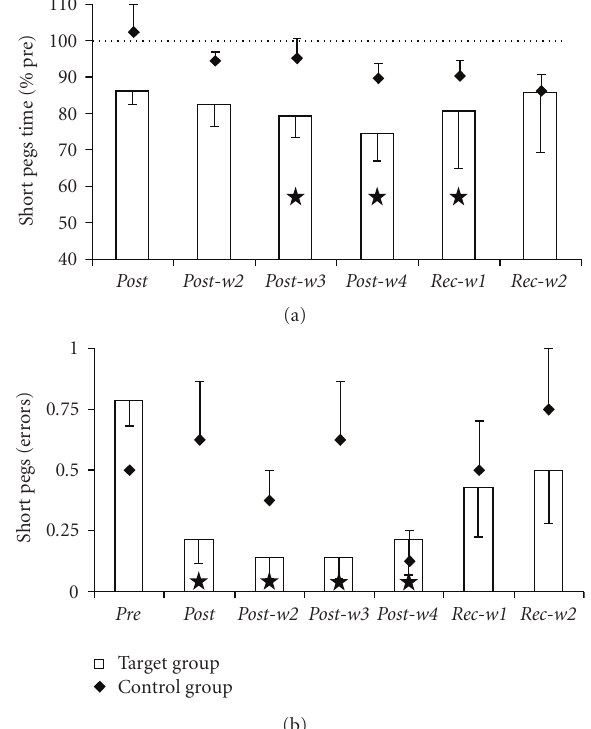
Figure 4: Fine motor performance in pegboard testing. (a) Percentage change of time to fulfill the pegboard test (short pegs) averaged across subjects of the target group (bars) and control group (diamonds) relative to their performance in the presession. Stars indicate significant changes ( P ≤ . 05) . (b) Same as (a) for the number of errors in the pegboard